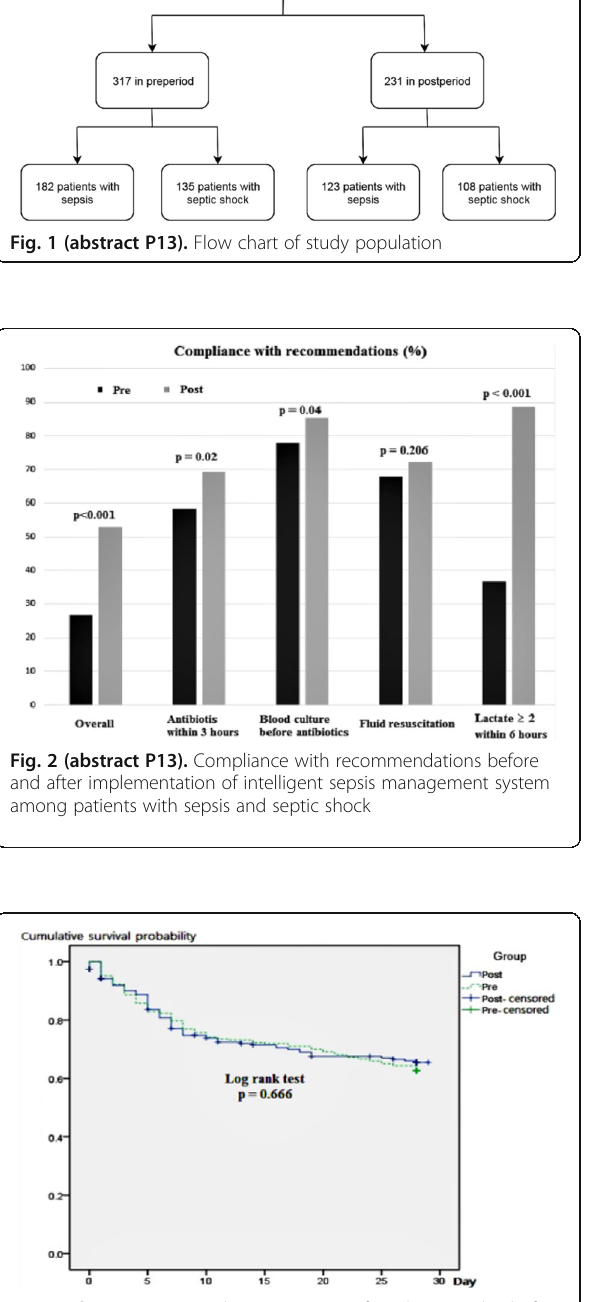
Fig. 3 (abstract P13). Kaplan-Meier curve of 28-day mortality before and after implementation of intelligent sepsis management system in patients with sepsis and septic Shock